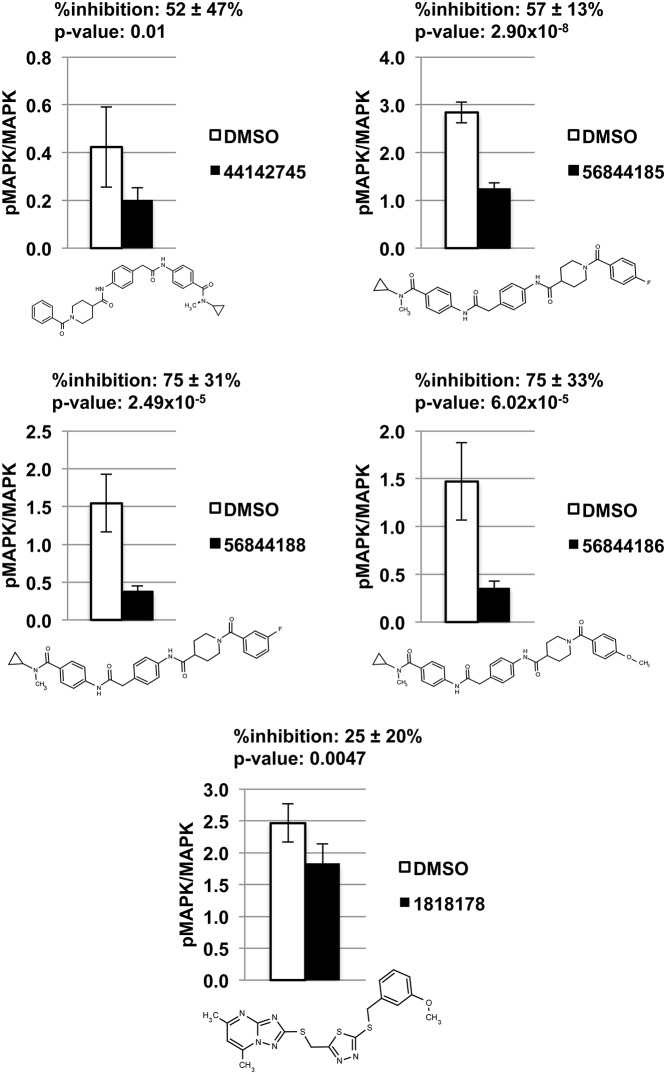
Five compounds significantly decrease MAPK1 phosphorylation in K562 cells.DMSO or compound was added to K562 cells at a final concentration of 1% or 10 μM, respectively, and incubated for 4 hours at 37°C before being lysed and analyzed by immunoblot with anti-pMAPK1/3 and anti-MAPK1/3. Each compound was tested with six biological replicates. Band intensity was quantified using LI-COR Odyssey, and the ratio of pMAPK/MAPK signal intensity is graphed for each compound and its DMSO control. Compounds are identified by their PubChem CID number.